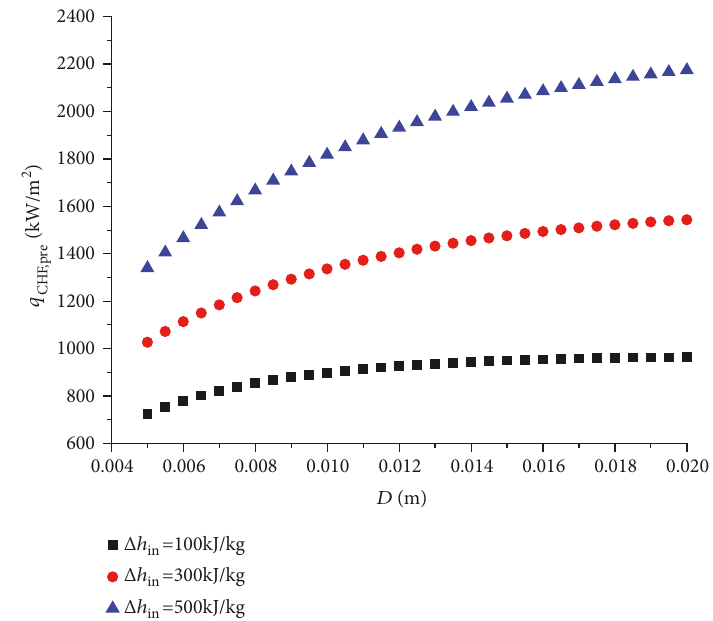
Figure 13: CHF as a function of tube diameter ( P =17MPa, G =1000kg/m 2 s, L=1m).